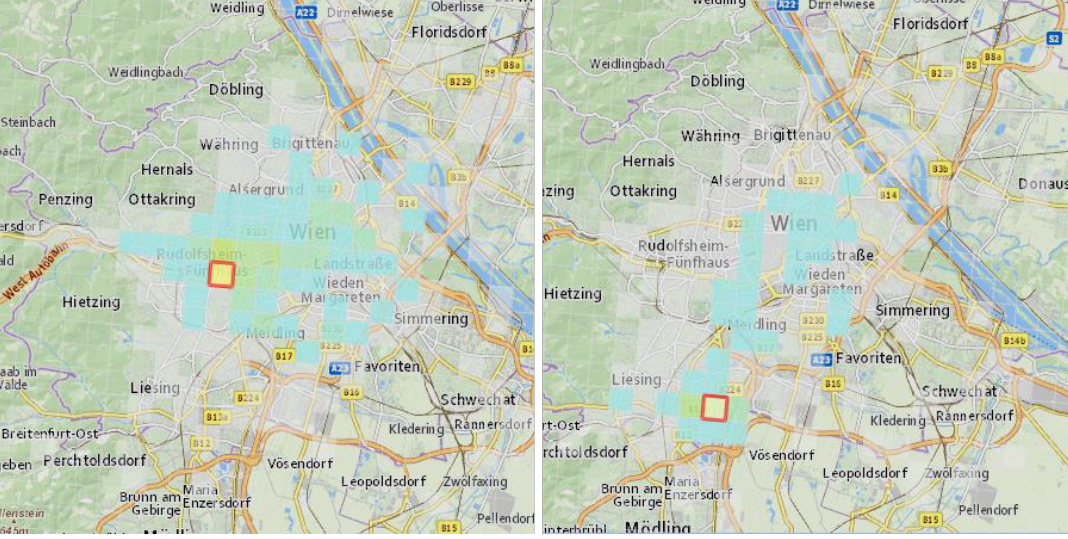
Figure 10. Comparison of target traffic from two different source cells (left versus right) at 14:30; source cell: red rectangle.